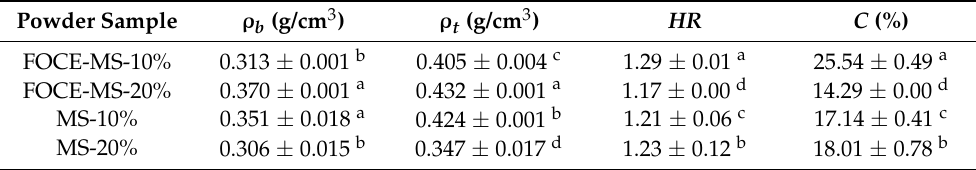
Table 3. Bulk density, tapped density, Hausner ratio ( HR ), and Carr index ( C ) of the spray-dried emulsion